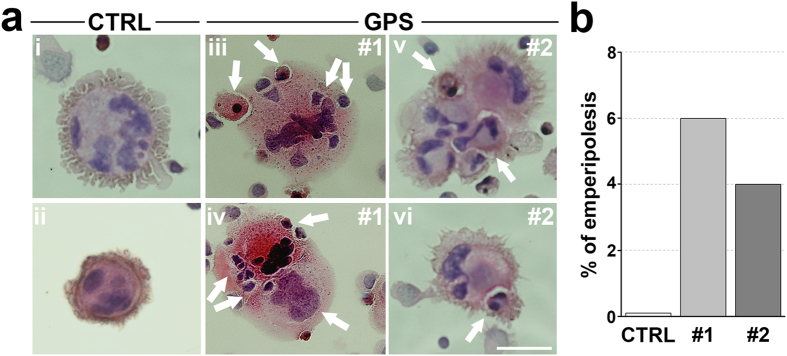
Emperipolesis in GPS cultured megakaryocytes: a distinctive feature of the disease is confirmed in in vitro model.(a) Representative hematoxylin and eosin staining of CTRL- (i–ii) and GPS-derived megakaryocytes (iii–vi). Arrows indicate intact cells that are going to and/or are already enclosed within megakaryocytes cytoplasm, thus indicating emperipolesis. (b) Percentage of emperipolesis in CTRL and GPS samples.